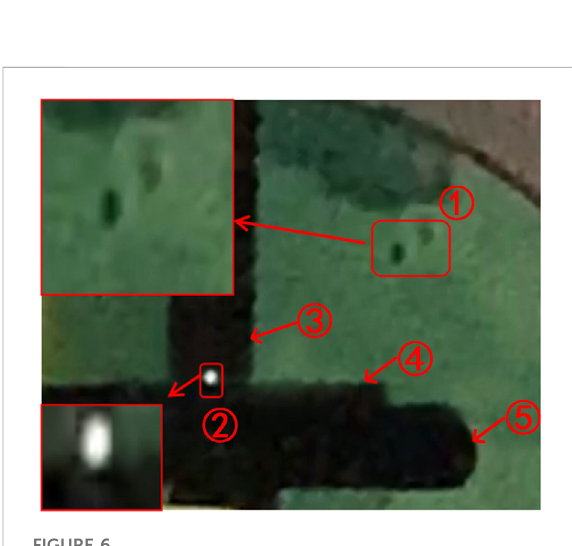
FIGURE 6 Spark discharge and bubble under test voltage grade 19 kV. FIGURE 7